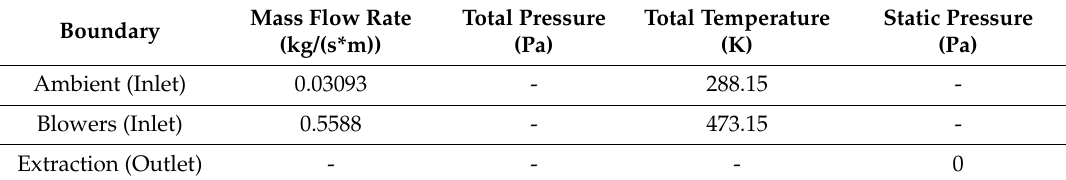
Table 5. Main boundary conditions assigned for CFD analyses.